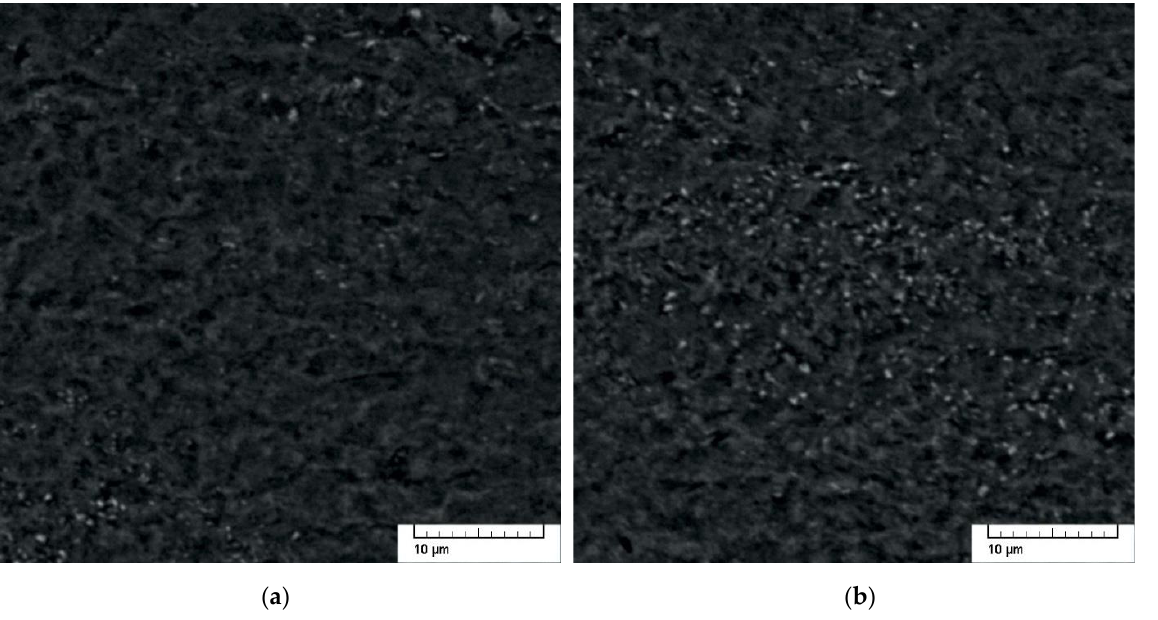
Figure 6. Images of the sample cross-section in the heat-affected zone: ( a ) close to the initial structure; ( b ) in the vicinity of the remelting zone.